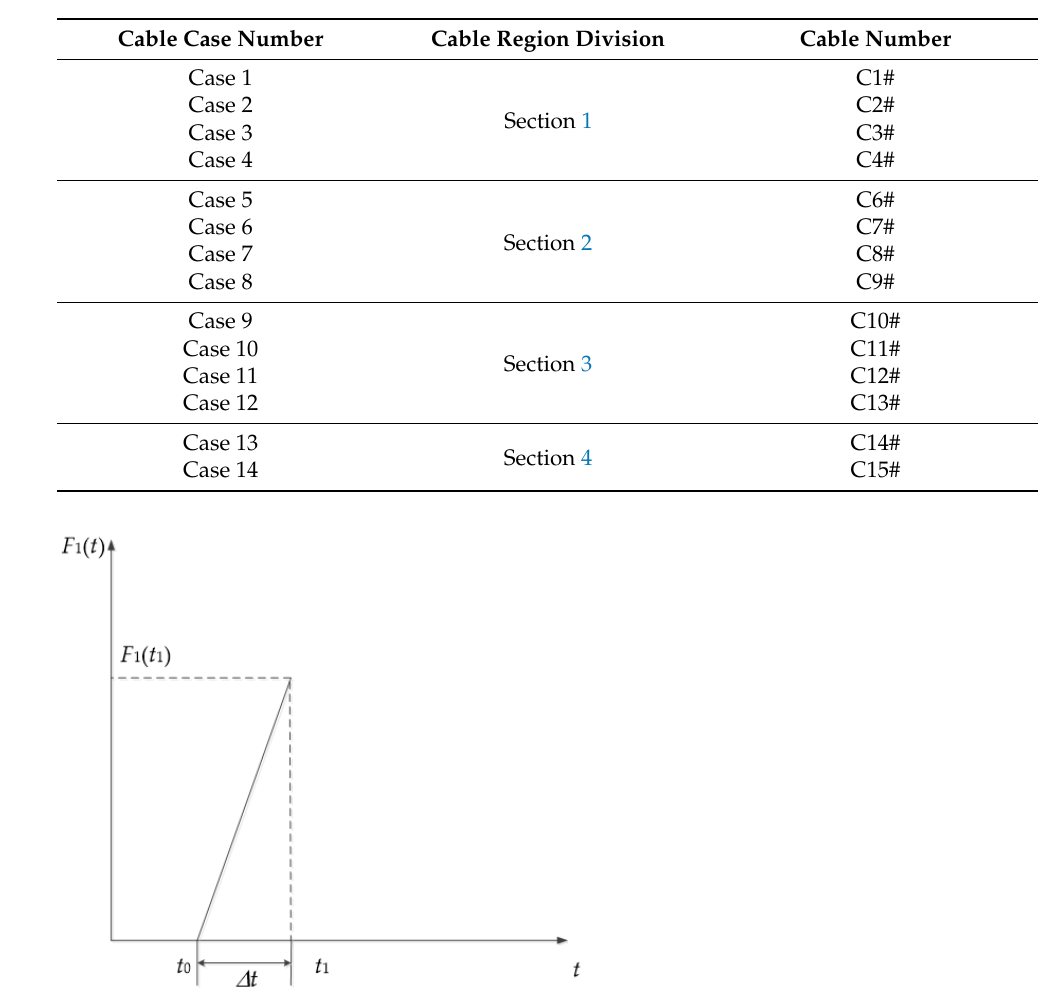
Figure 2. The time history value of the impact load of cable